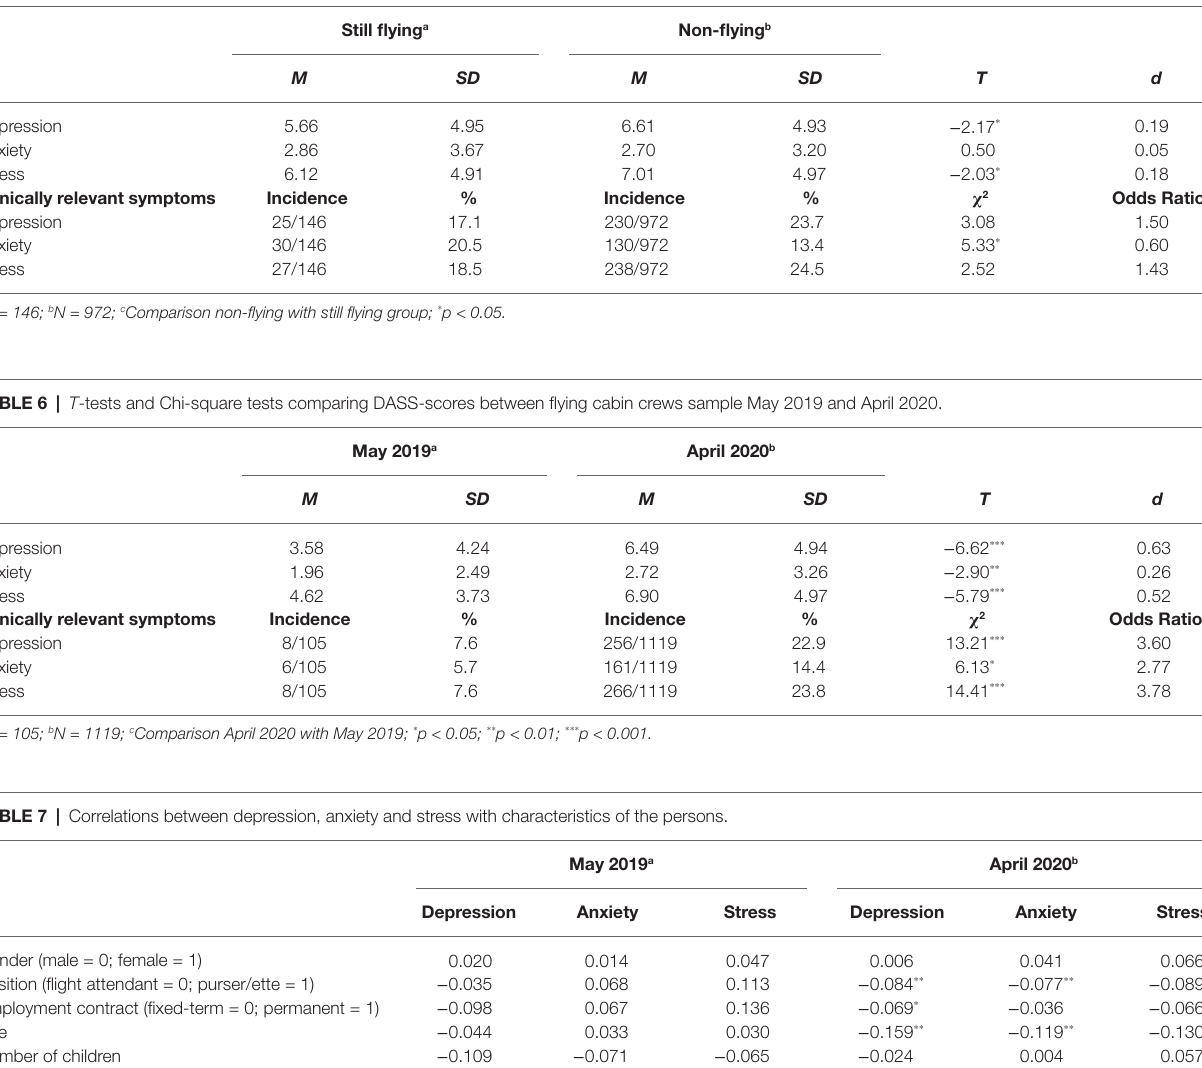
TABLE 5 | T -tests and Chi-square tests comparing DASS-scores of cabin crew members still flying with non-flying ones in April 2020. Still flying a